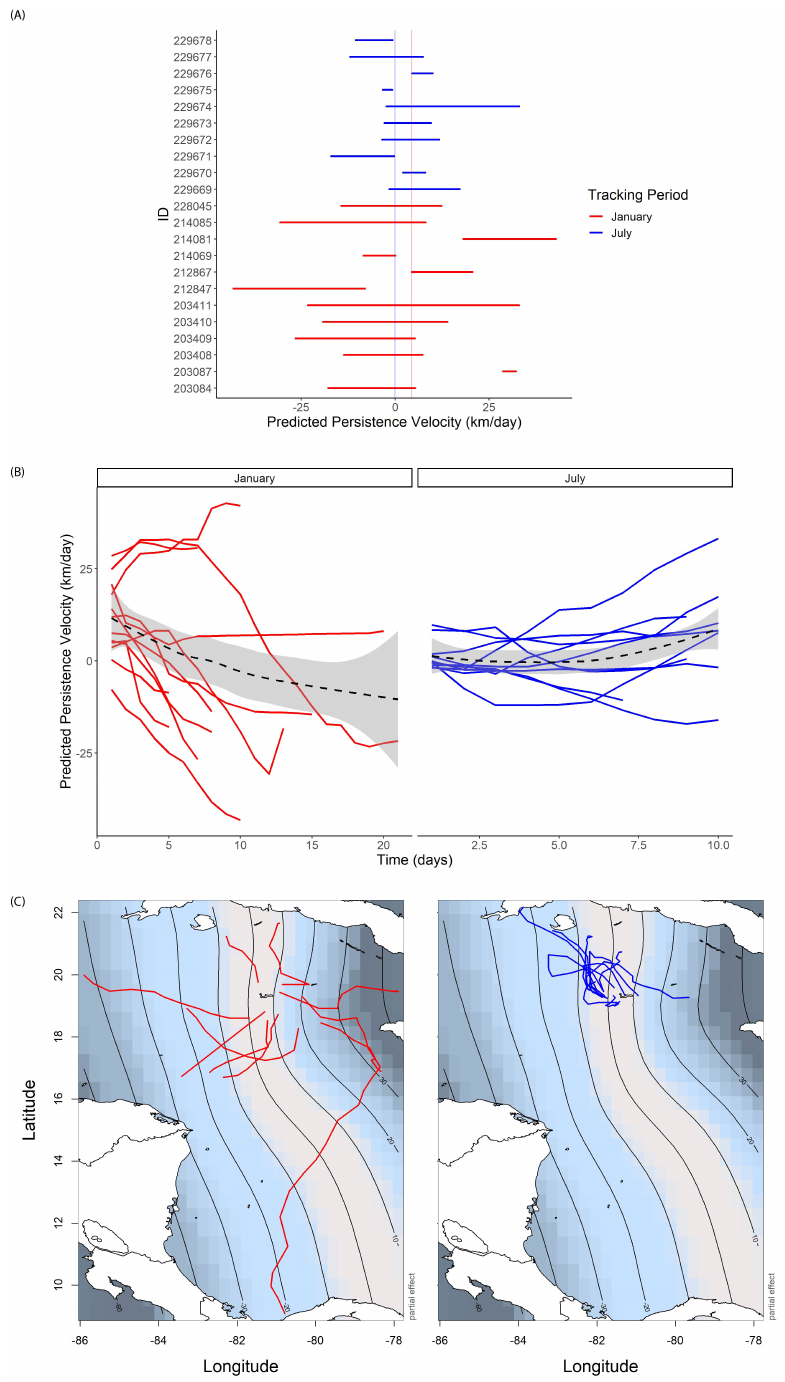
Figure 3. Predicted swimming persistence velocities from a fitted generalized additive mixed model (GAMM) for ( A ) individual turtles colored by tracking period (January, red; July, blue), with vertical bars showing median persistence velocity values for each tracking period; ( B ) individual turtles in January (red) and July (blue) over time, with generalized additive model smoothers (black line) and 95 percent confidence intervals (gray); ( C ) contour maps of the interaction of latitude and longitude with turtle trajectories overlaid for January (red) and July (blue).